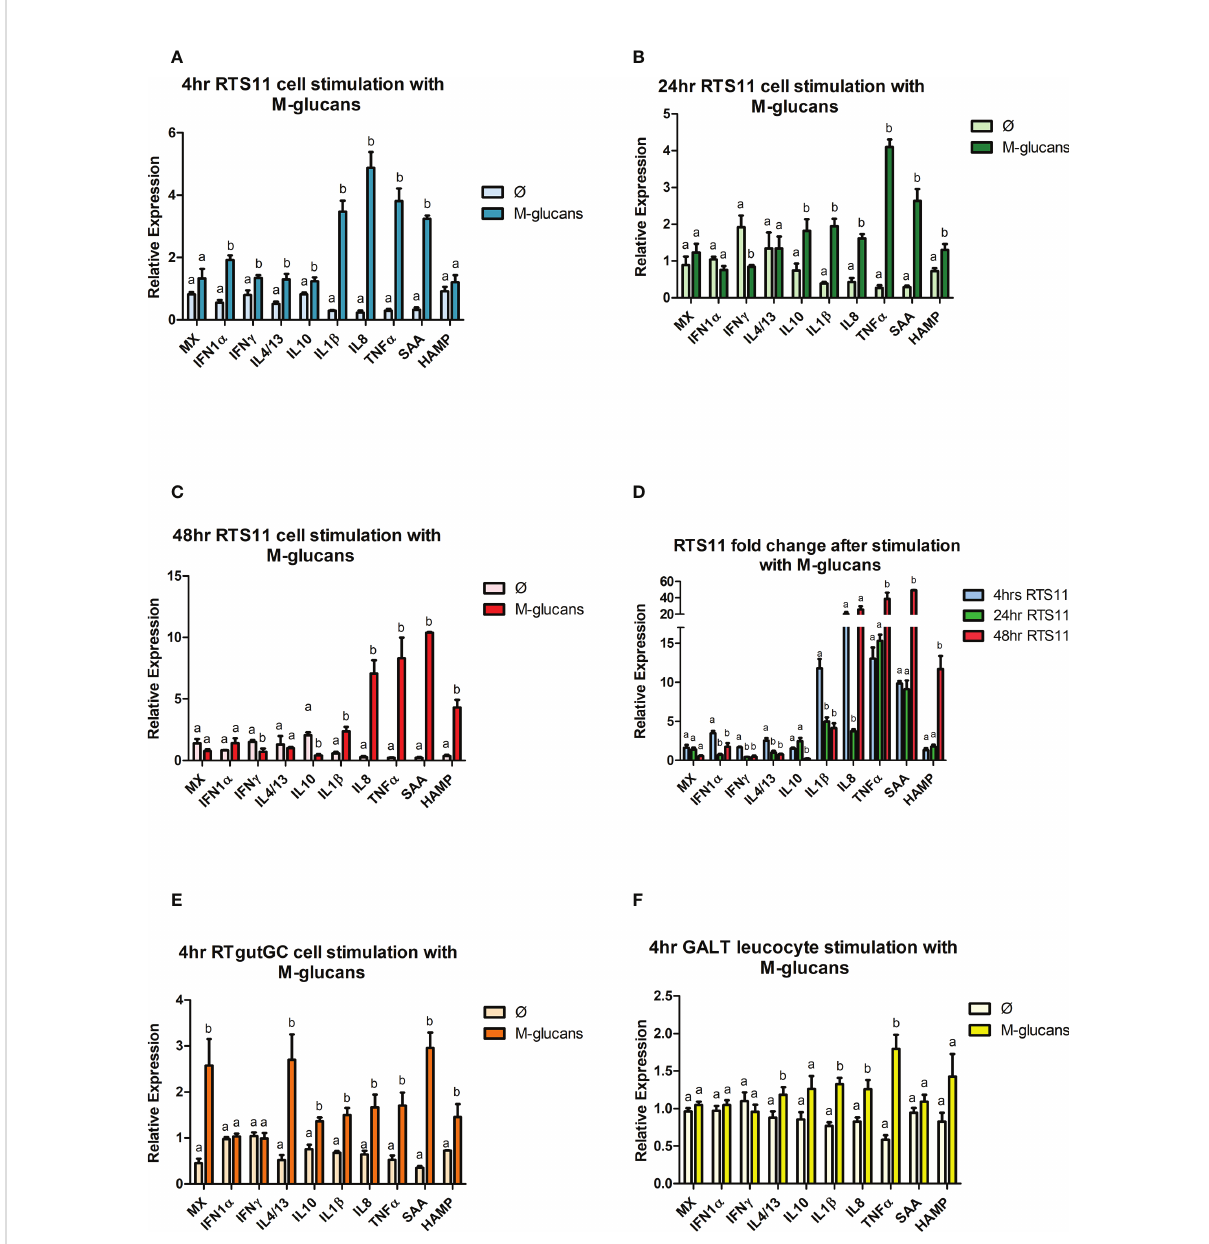
FIGURE 4 RTS11, RTgut and GALT leucocyte response to M-glucans. (A) RTS11 4hr M-glucans stimulation showing relative expression. (B) RTS11 24hr M- glucans stimulation showing relative expression. (C) RTS11 48hr M-glucans stimulation showing relative expression. (D) RTS11 Fold Change between time points (4, 24 and 48 hr). (E) RTgutGC 4hr M-glucans stimulation showing relative expression. (F) GALT leucocyte 4hr M-glucans stimulation showing relative expression. For relative expression samples were compared between stimulated and unstimulated samples. a and b denote a signi fi cant difference where p <